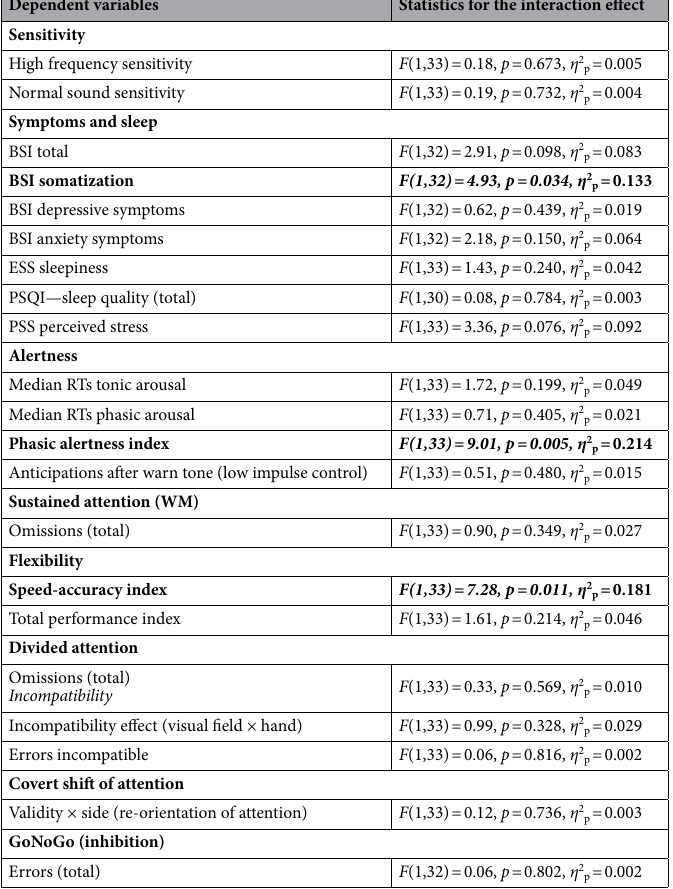
Table 2. Results (group × time interaction effects) of the repeated measures ANOVAs for all behavioral variables. Alpha level = 0.05; Bonferroni-adjusted = 0.05/21 = 0.0024. After application of the corrected p -level none of the significant effects (reported here with unadjusted level, highlighted in bold in Table) remain. The likelihood of by chance detecting a significant result is 5%, with 21 tests this equals 1.05 tests that would be detected as significant by pure